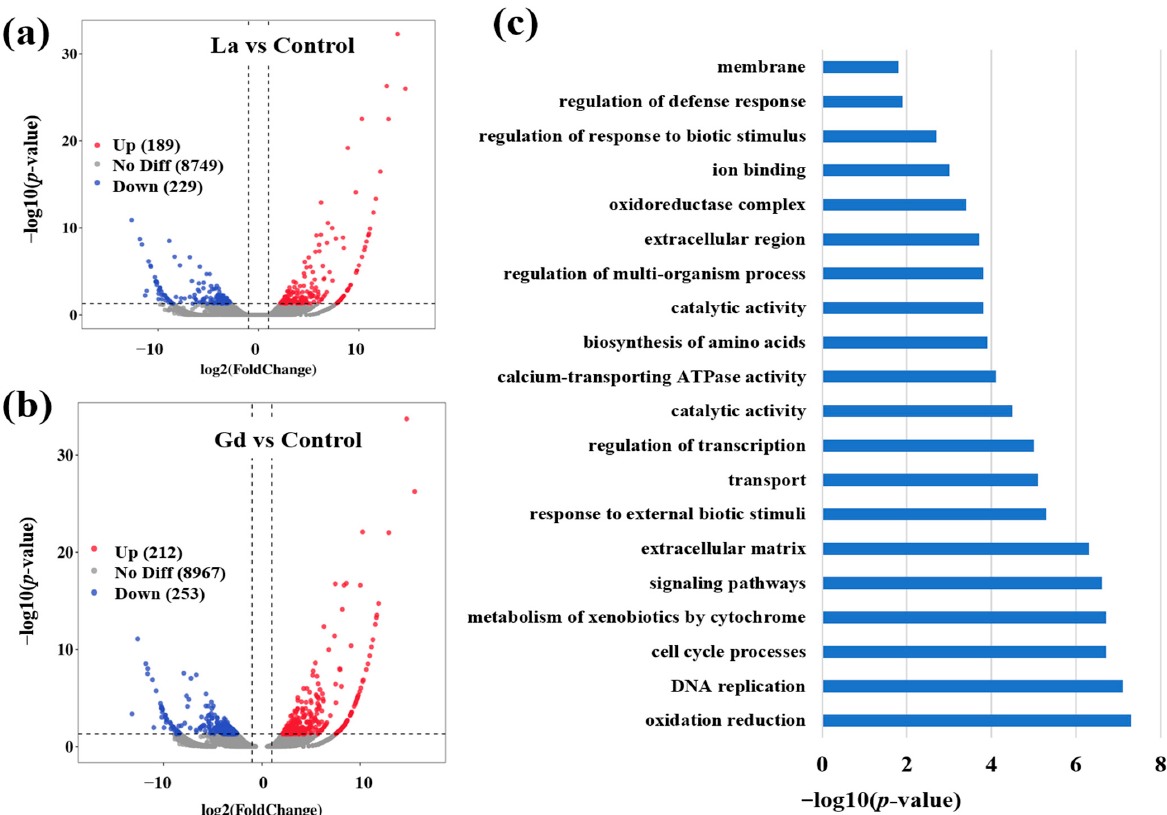
Figure 2. Transcriptome high-throughput sequencing analysis in liver tissues of Danio rerio exposed to 30 µ mol L − 1 La and Gd: ( a , b ) volcano plots of DEGs in La and Gd, compared with the control, respectively. The red dots indicate upregulated genes, blue dots indicate downregulated genes, and gray dots indicate nonsignificant DEGs; ( c ) analysis of the shared GO classification of DEGs between La and Gd.